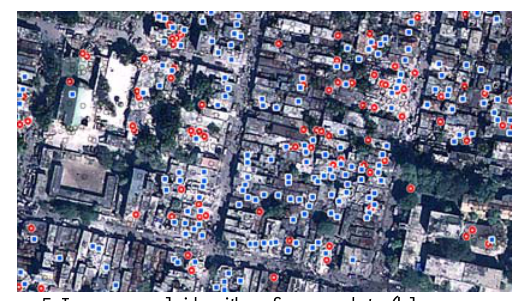
Figure 5 Image overlaid with reference data (blue squares rep- resent totally collapsed buildings) and centre points of segments classified as collapsed buildings (red